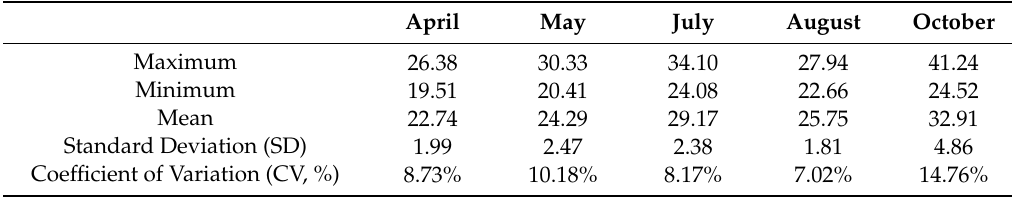
Coe ffi cient of Variation (CV,